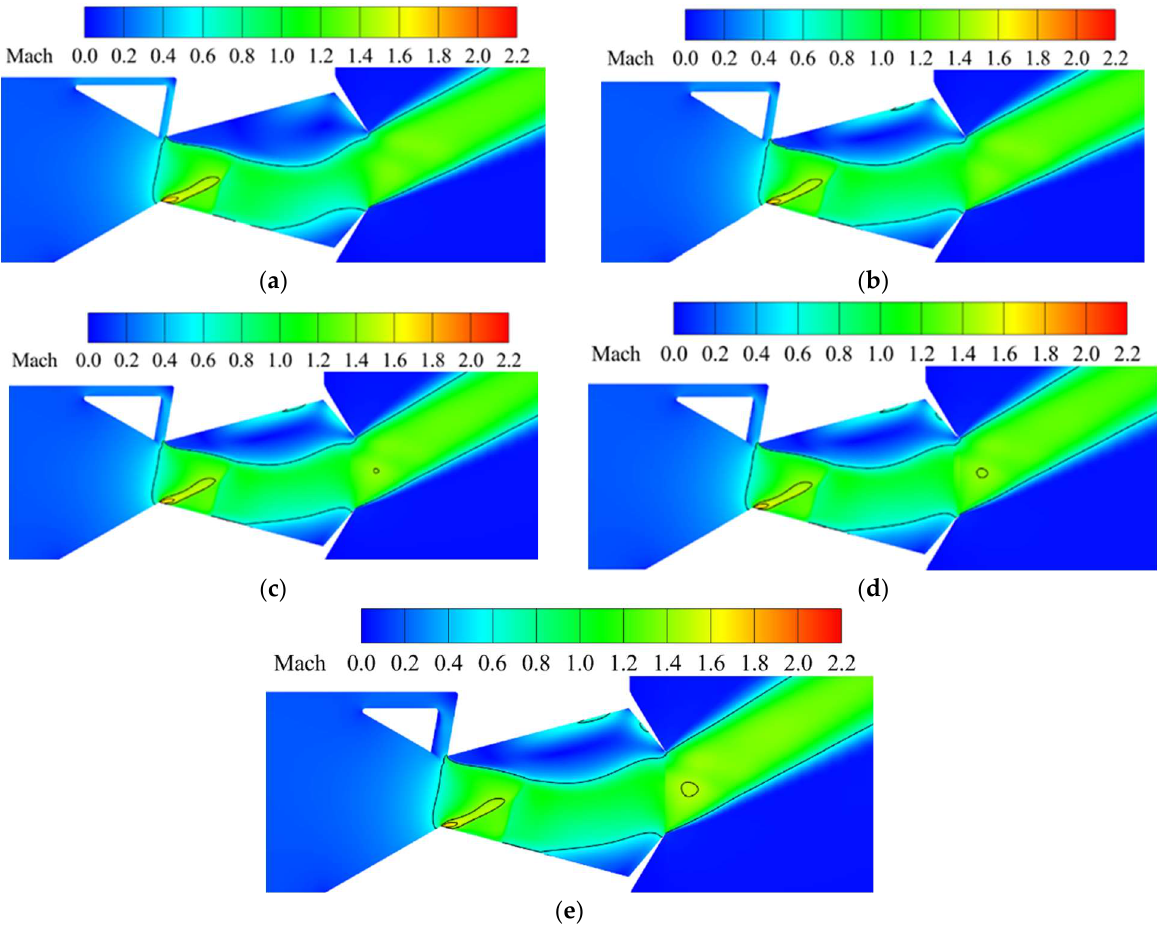
Figure 9. Mach contours on the center-plane at NPR = 3, θ 2 = 70 ◦ and θ 1 = 30 ◦ for bypass width of ( a ) 2.7 mm ( b ) 3.2 mm ( c ) 3.7 mm ( d ) 4.2 mm ( e ) 5 mm.